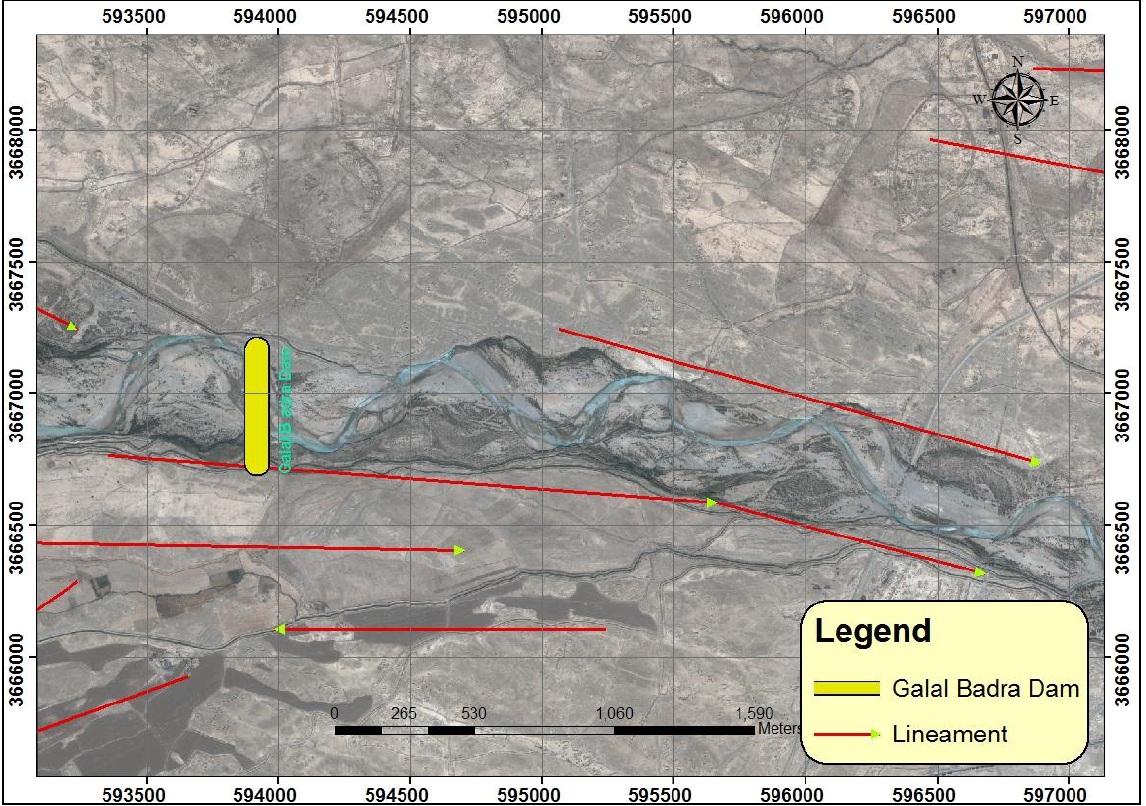
Fig.11: Lineaments effect for Galal Badra dam